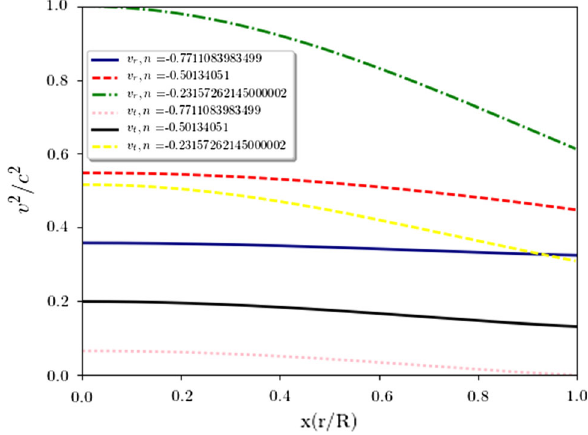
Fig. 4 Graphical representation of the radial and tangential